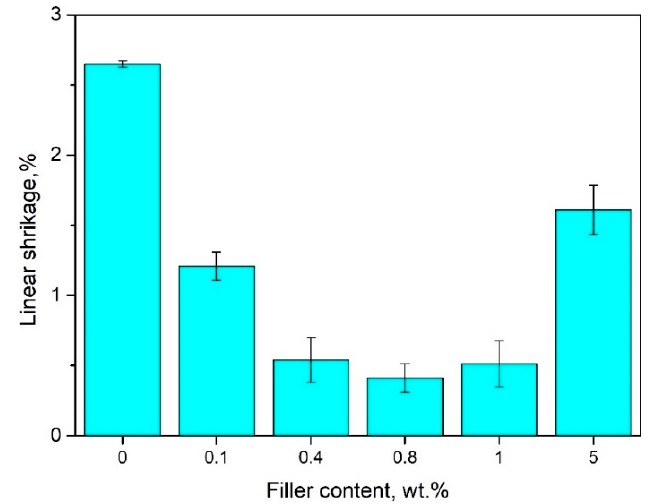
Figure 9. Linear shrinkage of pure PE-wax filled with various amounts of bentonite.